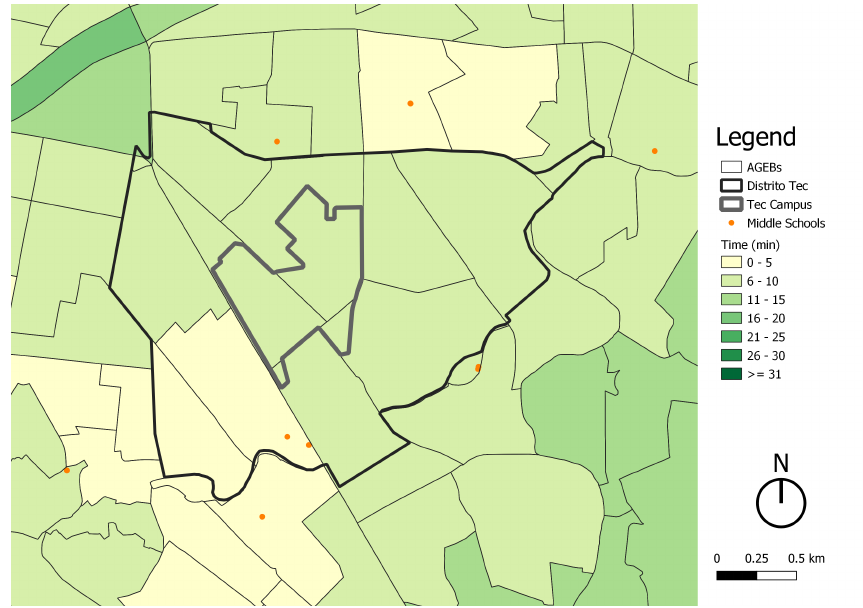
Figure 15. Distrito Tec average travel time to the 3 closest public middle schools by bicycle.